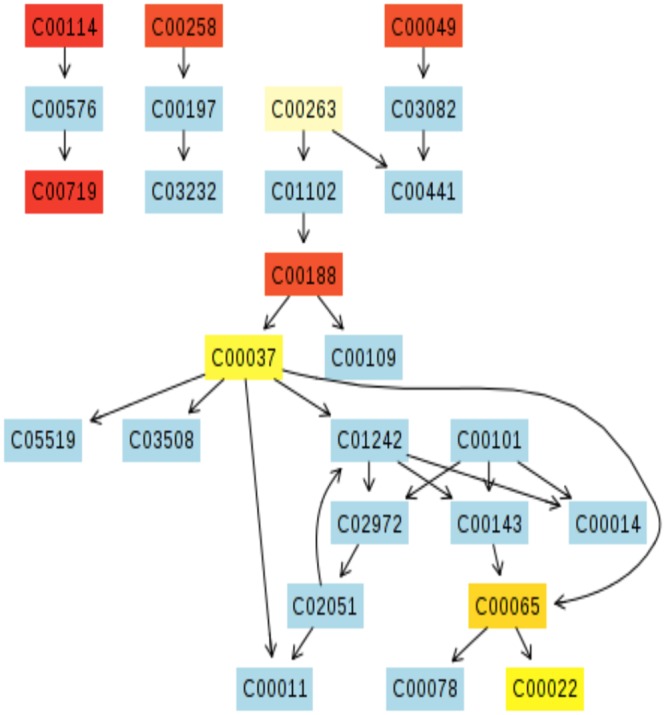
Putative metabolic pathways associated with the wound environment of chronic pressure ulcers.Significantly contributing pathway nodes include glycine, serine, and threonine metabolism. Highlighted metabolites indicated hits from the metabolic profiling and are coded according to p-value. Pathway maps are generated using the KEGG reference map (http://www.kegg.jp/kegg/pathway.html).